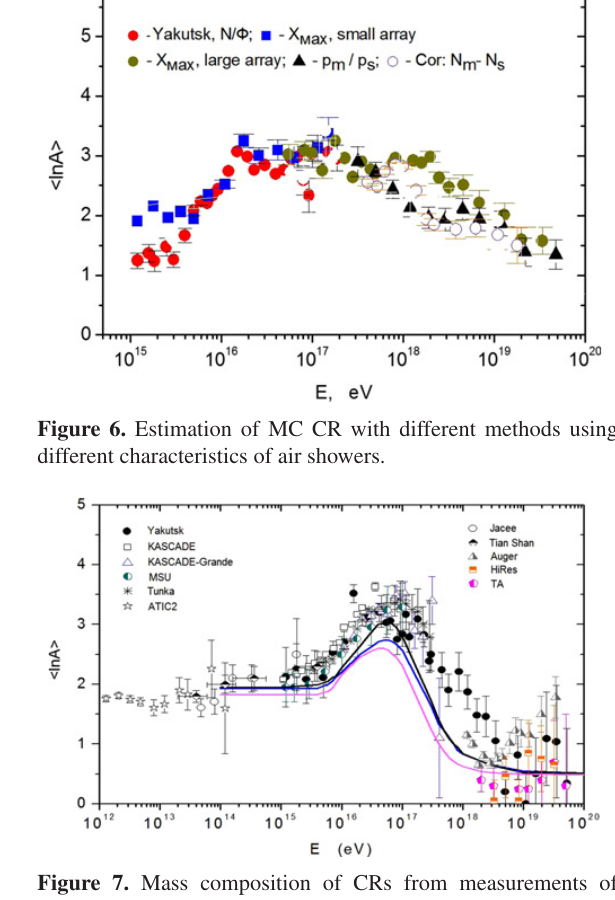
Figure 7. Mass composition of CRs from measurements of different EAS arrays. Lines show MC calculated from paper [16] in the case of near